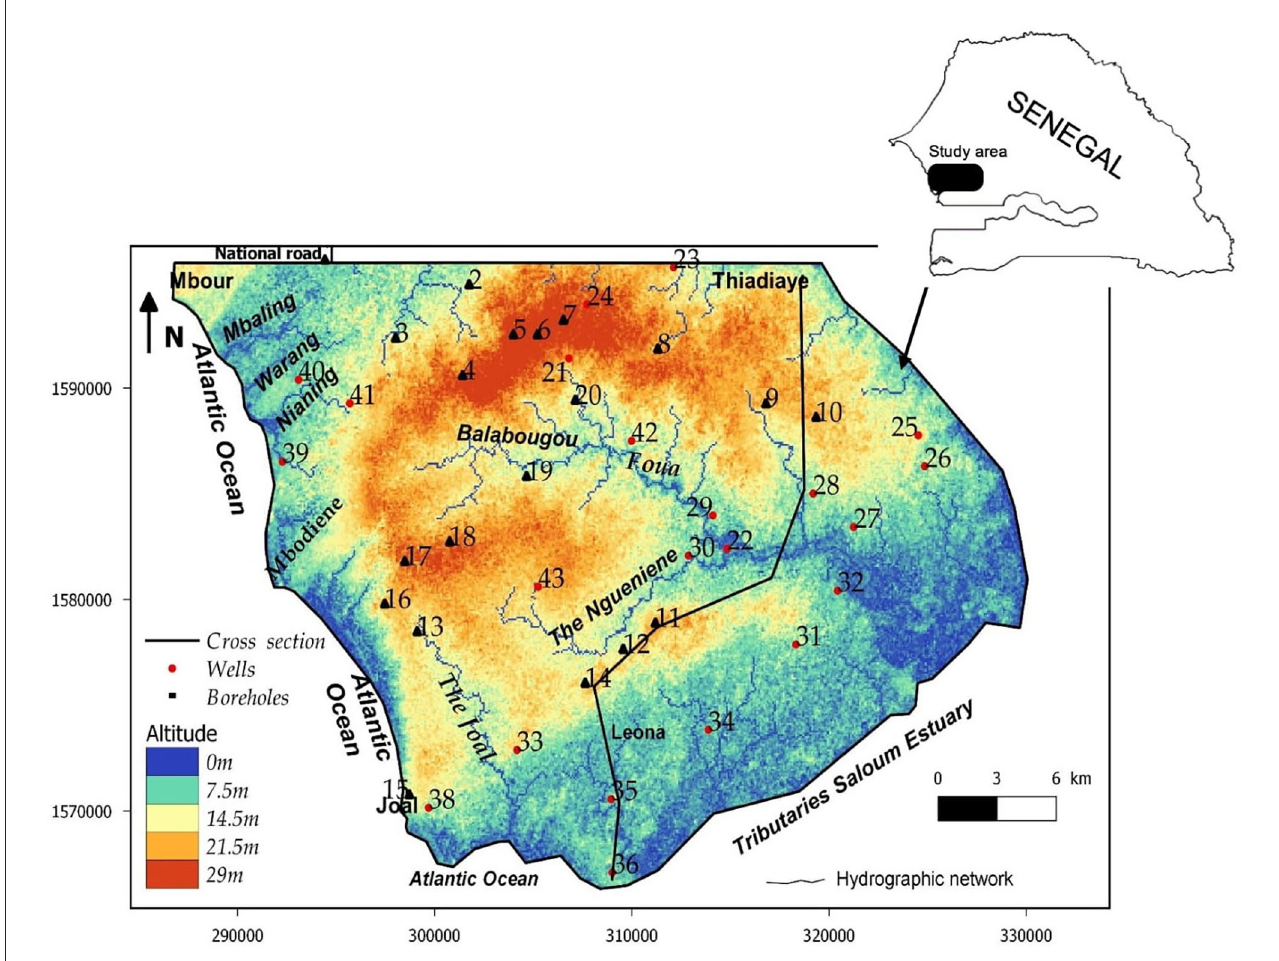
FIGURE1 Location of the study area and sampled Wells (small frame corresponds to Senegal